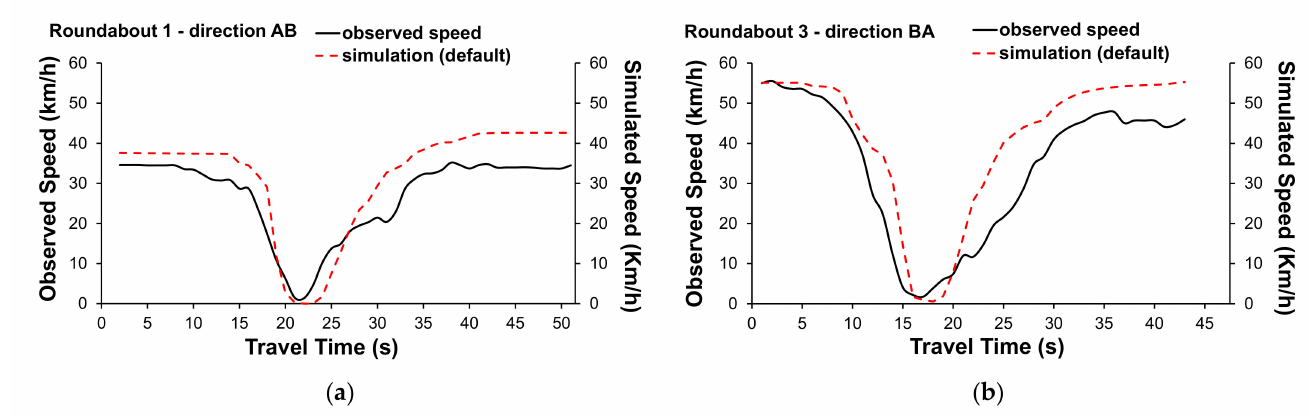
Figure 6. Observed vs. simulated speed-time profiles at: ( a ) Roundabout 1 (movement AB) in Figure 2a; ( b ) Roundabout 3 (movement BA) in Figure